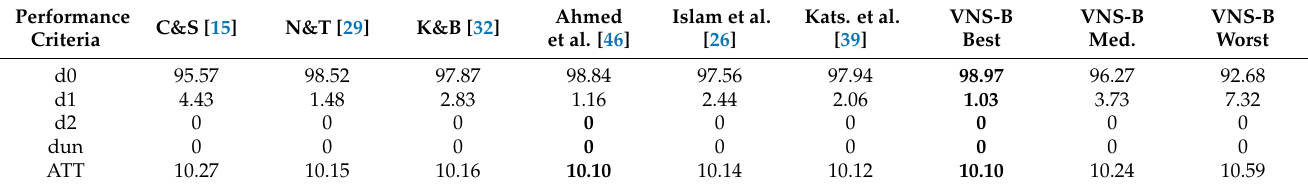
Table 5. Comparison of the final solution generated between methods for 7-Route